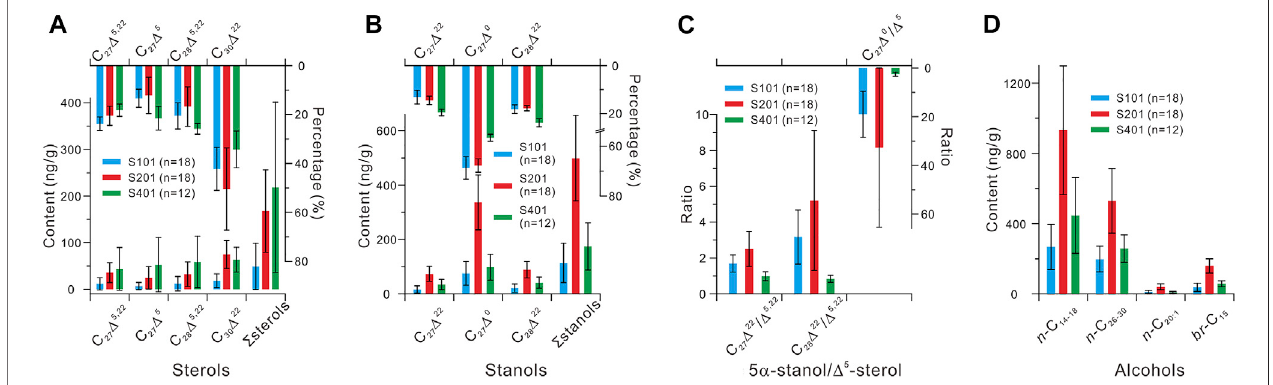
FIGURE 3 | Average abundances of sterols (A) , stanols (B) , and alcohols (D) , and average ratios of 5 α -stanol/ Δ 5 -sterol (C) in the three cores. The percentage of each individual sterol and stanol is calculated relative to (cid:4) sterols and (cid:4) stanols, respectively. Error bars indicate the standard deviations.